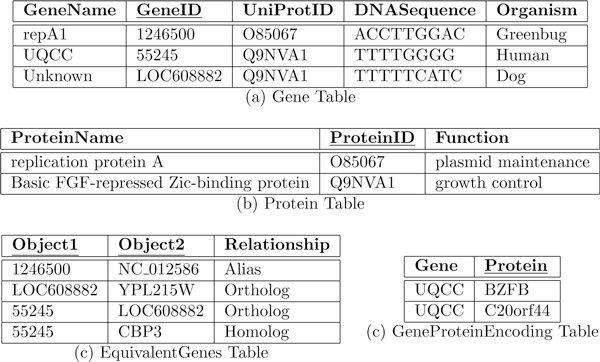
Example database Δ.